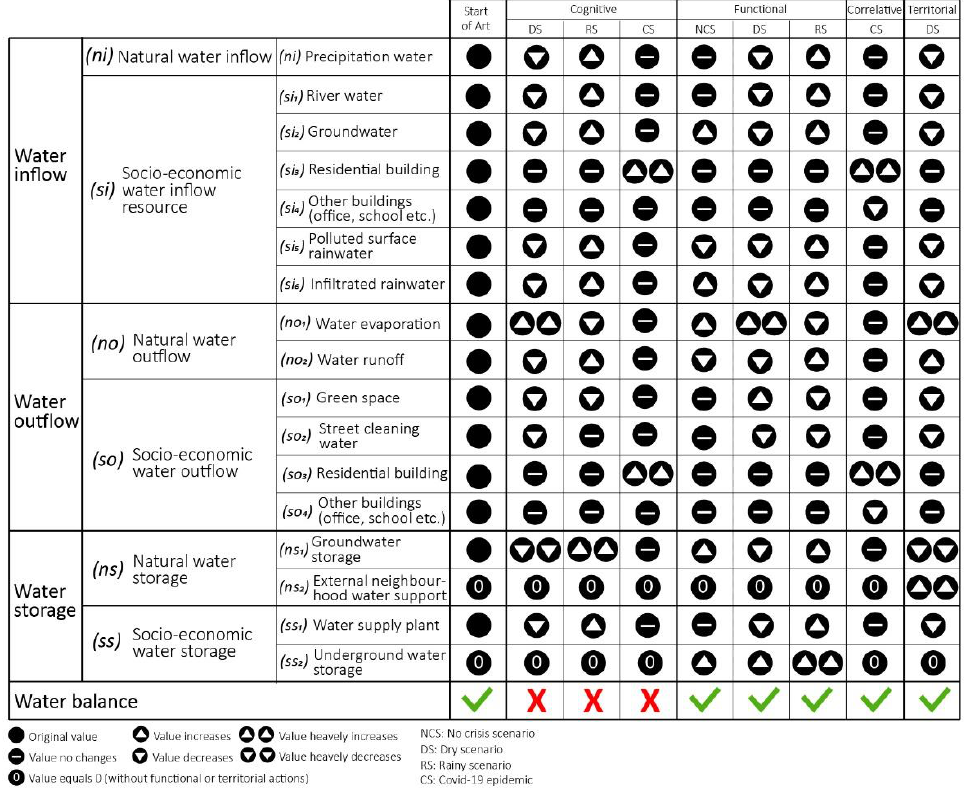
Figure 12. Changes in indicators and sub-indicators in the Part-Dieu neighbourhood in Lyon, after applying resilience actions.